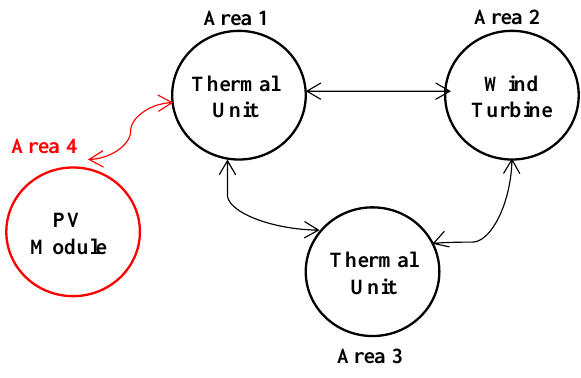
Figure 6. The PV/WT/thermal